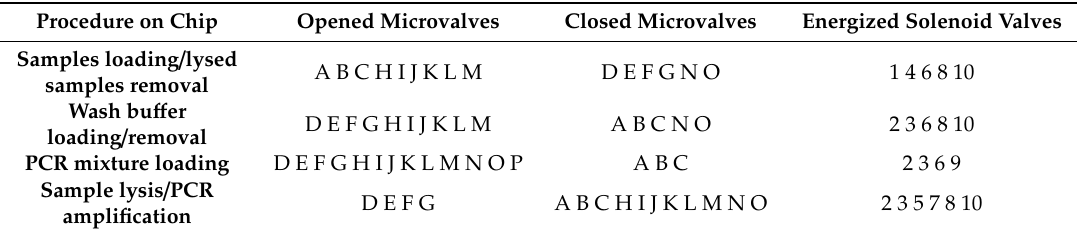
Table 1. Opened / closed microvalves and energized solenoid valves in di ff erent